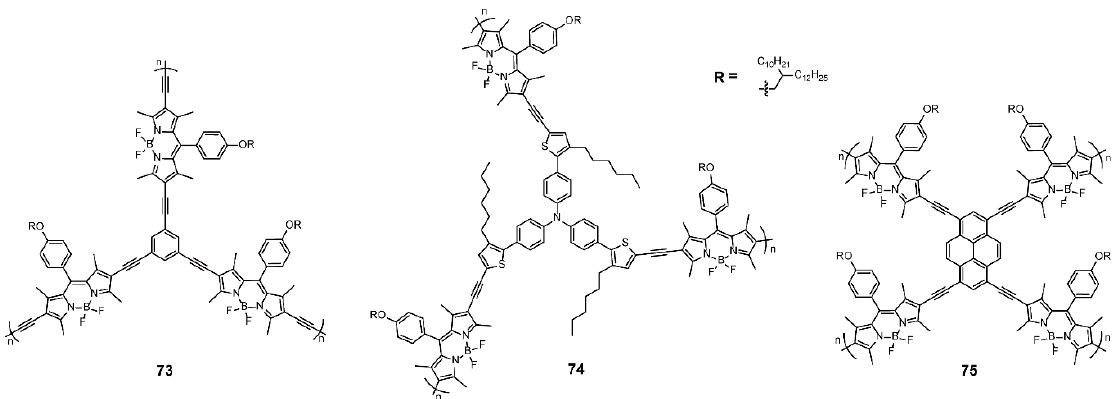
21 of 32 Figure 24. ( a ) Chemical structures of polymer 72 . ( b ) Visual color changes and emission changes ( λ ex = 365 nm) of 72 (c = 10 μ M) in tetrahydrofuran/H 2 O (98:2, v / v ) in the presence of different anions (Reproduced with permission from Reference [96]. Copyright @ 2015 Elsevier). Valiyaveettil and coworkers [98] synthesized a series of hyperbranched conjugated polymers (Figure 25) based on BODIPYs for detecting organic vapors. To study the influ- ence of polymer conformation on vapor sensing, the authors developed 73 and 74 as A 2 B 3 - type hyperbranched conjugated polymers with benzene and triphenylamine between BODIPY moieties respectively, with 75 as an A 2 B 4 -type hyperbranched conjugated poly- mer with pyrene between BODIPY moieties. These hyperbranched conjugated polymers all displayed solvent effect in different solvents. Polymer 73 possessed a more planar con- formation, which resulted in emission quenching at solid state. The twisted conformation